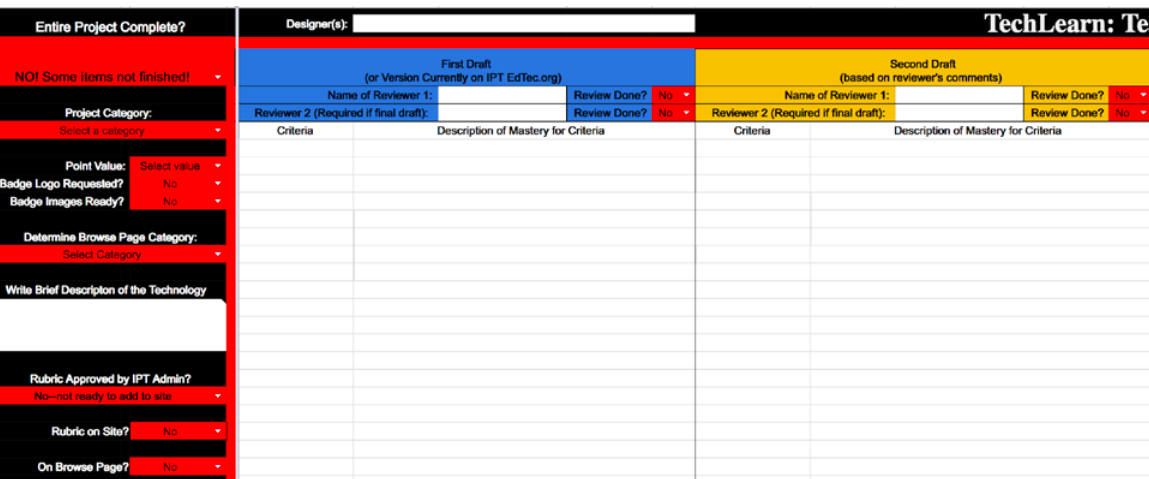
Figure 5 . An example of one of the Google Sheets rubrics used to scaffold new badge designers. This scaffolding was done through the process of drafting and revising a new educational technology badge,